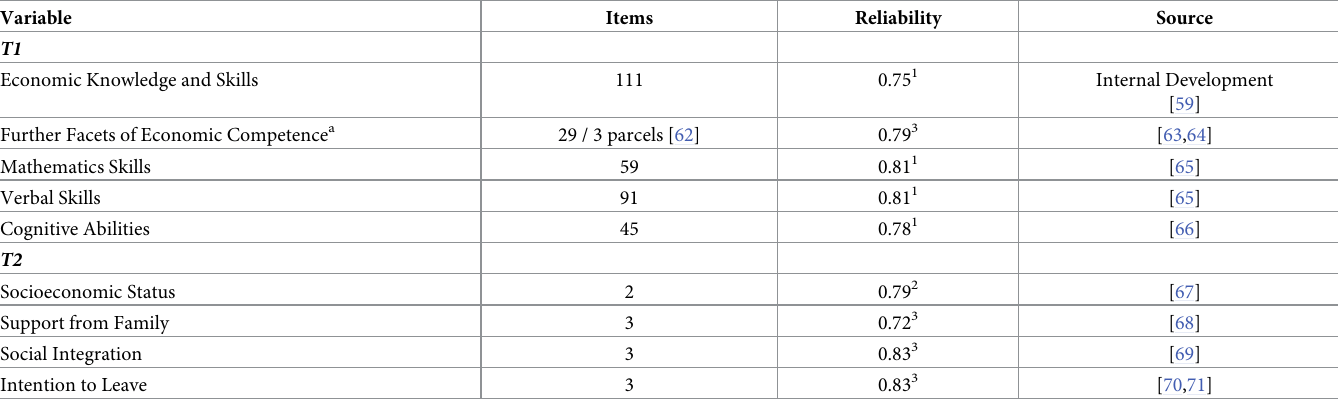
Table 5. Overview of instruments at T1 and